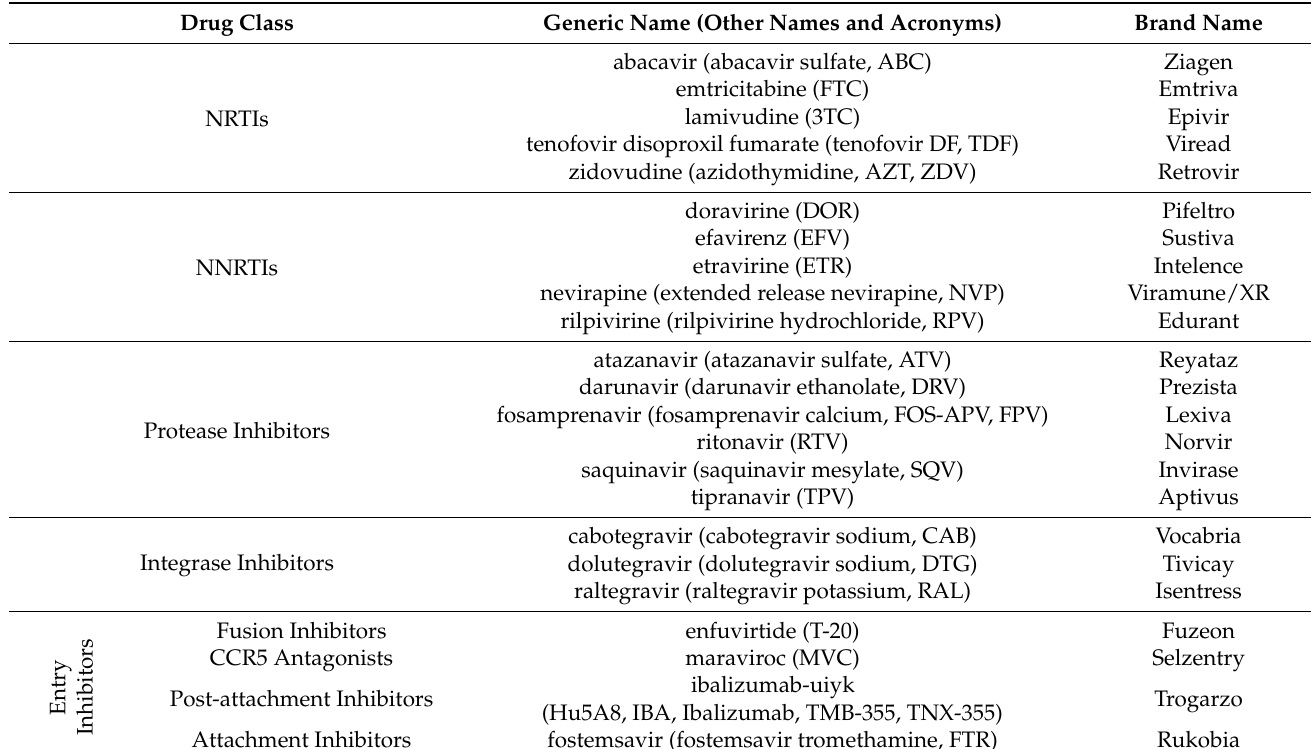
Table 1. Currently approved antiretroviral drugs for HIV-1